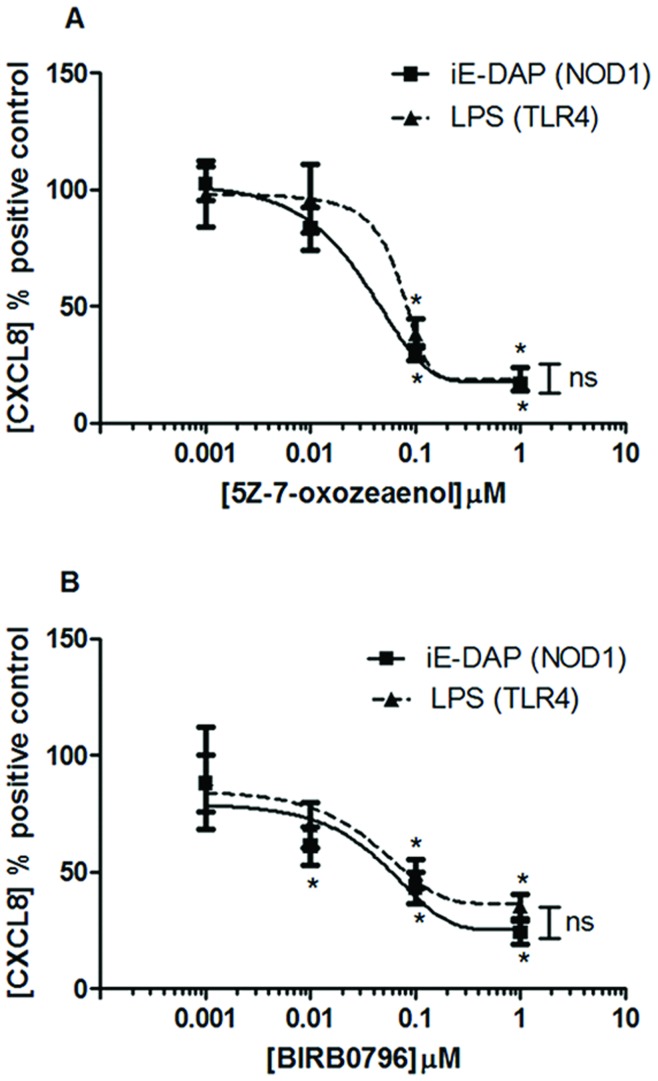
Role of TAK1 and p38 MAPK on NOD1 and TLR4 ligand mediated CXCL8 release by HMVEC.CXCL8 release at 24 hours in HMVEC stimulated by iE-DAP 10 µg/ml (NOD1 agonist) or LPS 1 µg/ml (TLR4 agonist) following 30 minutes pre-treatment with (A) the TAK1 inhibitor 5Z-7-oxozeaenol and (B) the p38 mitogen activated protein kinase (p38 MAPK) inhibitor BIRB0796. Results are expressed as a percentage of response to the agonist alone (mean ± SEM; n = 4). Results were analysed by 1-sample t-test (*P<0.05) and by 2-way ANOVA (#P<0.05 vs. LPS).